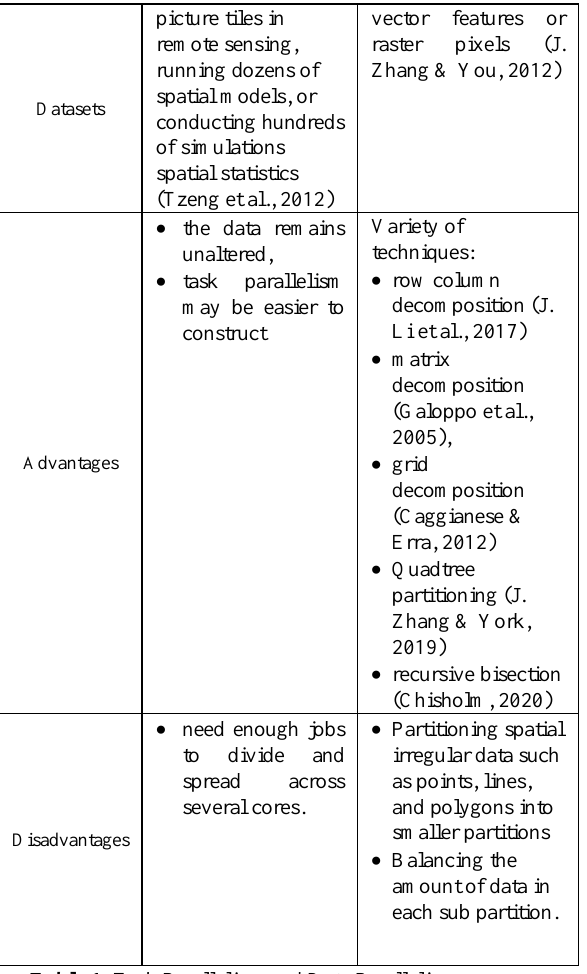
Table 1. Task Parallelism and Data Parallelism summary